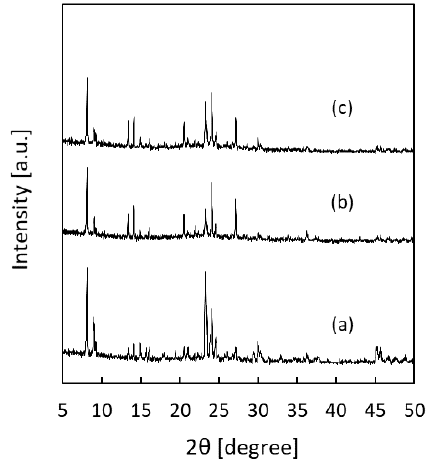
Figure 4. XRD patterns of silicalite-1 membranes prepared by the gel-free SAC method using different silica supports. ( a ) Uncoated support for 24 h, ( b ) spherical-silica-particle-coated support for 24 h, and ( c ) fumed-silica-particle-coated support for 16 h.